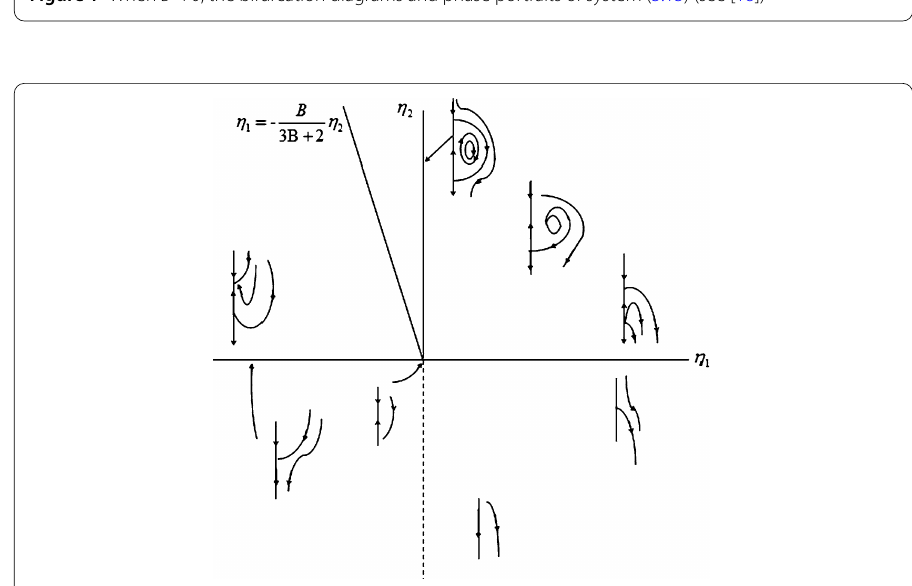
Figure 2 When B > 0, the bifurcation diagrams and phase portraits of system (3.13) (see